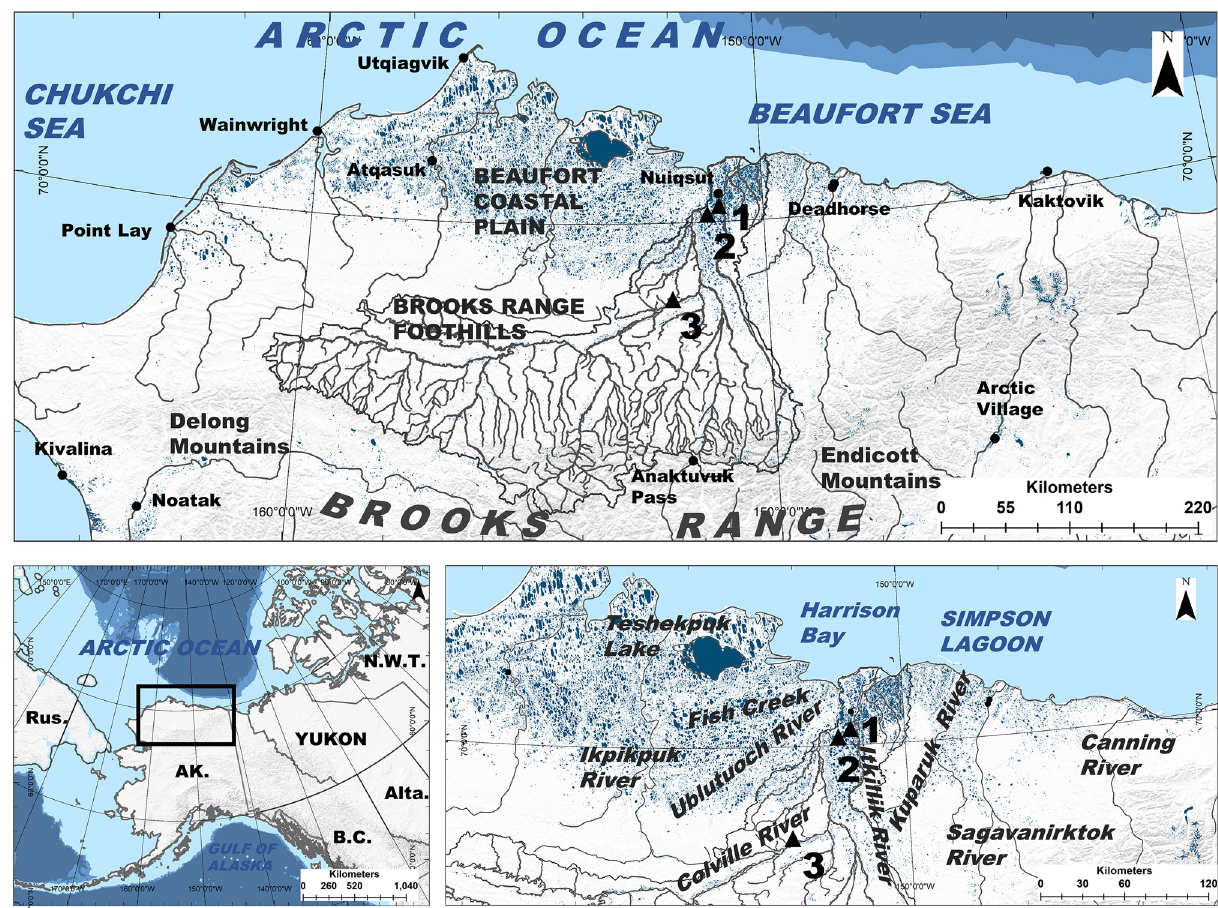
Fig 1. Study area. The Central Beaufort Sea region in Arctic Alaska, situated between the Ikpikpuk and the Canning rivers, AK, contains a diversity of aquatic habitats. The large Colville River, AK, USA (ca. watershed area 60,000 km 2 ), located in the middle of the Central Beaufort Sea coast, AK, contains minor and major tributaries (grey lines) that drain from the Brooks Range, AK that flow toward a large delta on the edge of the Beaufort Sea, near the community of Nuiqsut, AK. We collected fish at three sites (black triangles) within the Colville River (site 1 = Itkillik, site 2 = Puviksuk, site 3 =